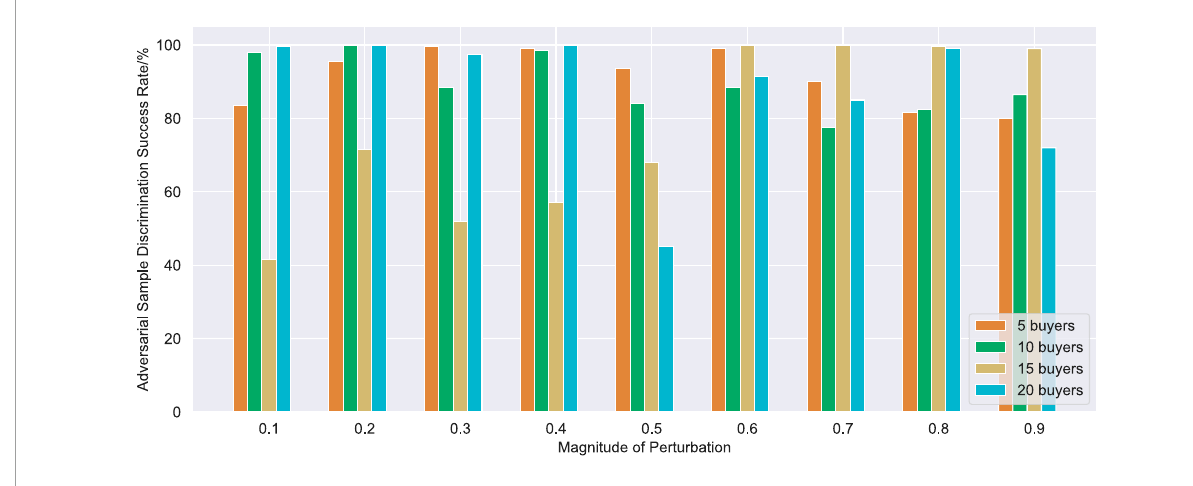
FIGURE 7 Effect of adversarial sample discriminator for buyer Q-Network.